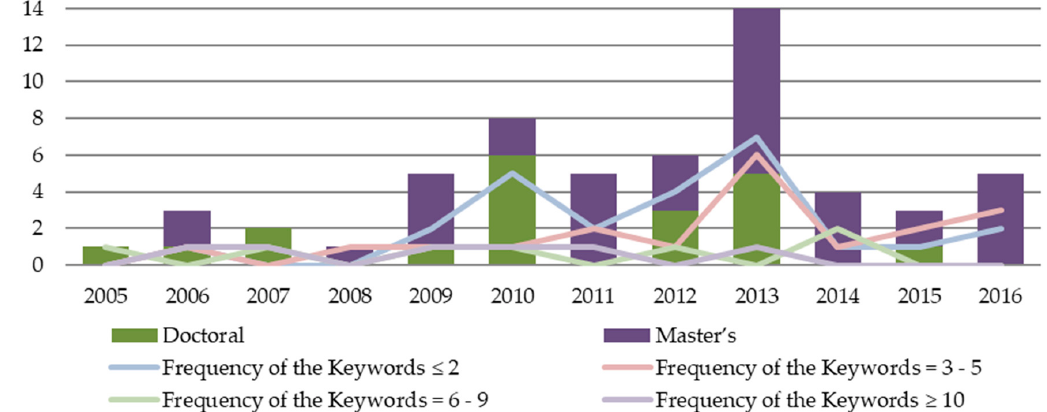
Figure 2. Frequency of the sample Chinese dissertations that address the concept of religious diversity (2005–2016).